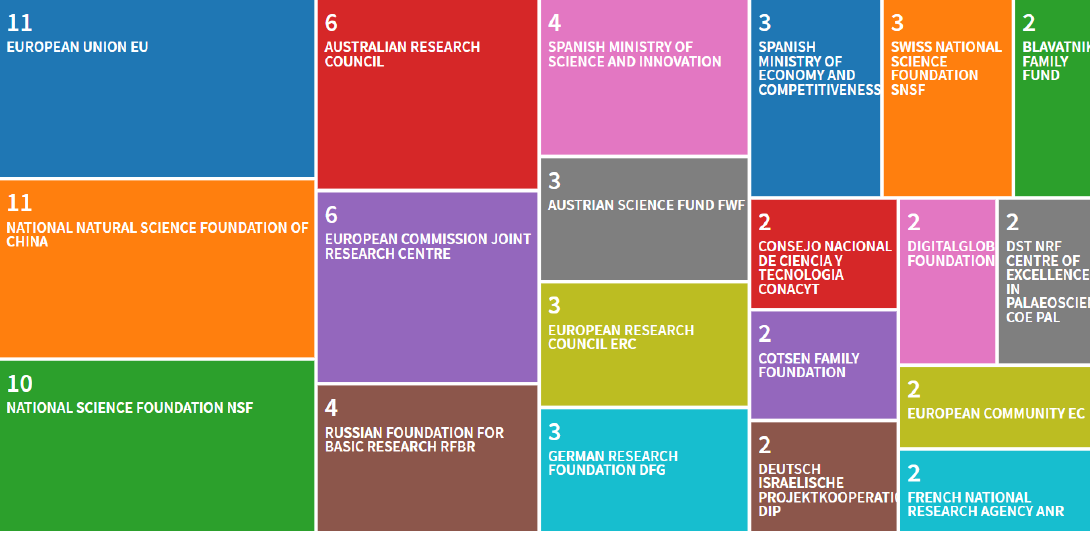
Figure 5. Top funding agencies for archaeological MI research published in Web of Science. These do not represent the total number of published studies, but illustrate disparities within certain journals (source, Web of Science). Results from Microsoft Academic indicate similar results.